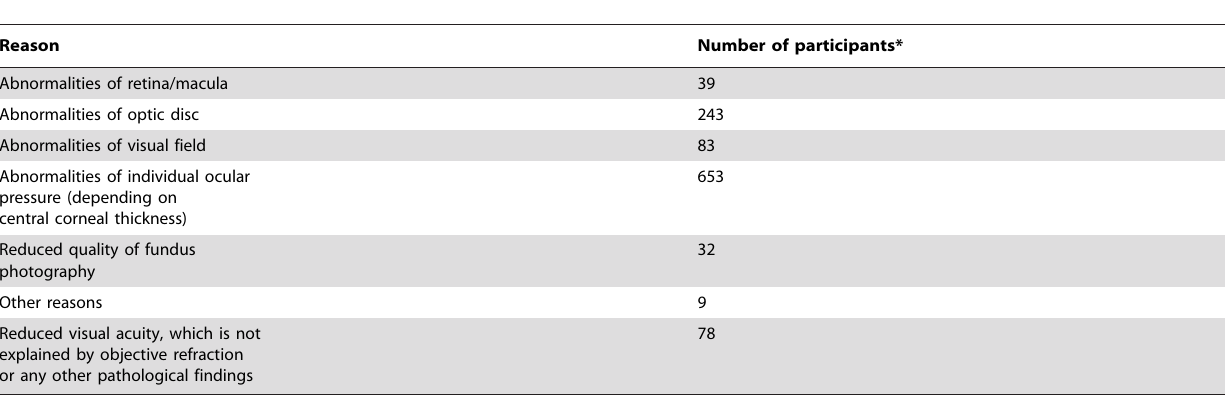
Table 10. Recommendation to consult a general ophthalmologist due to abnormalities in fundus photography, perimetry and/or intraocular pressure